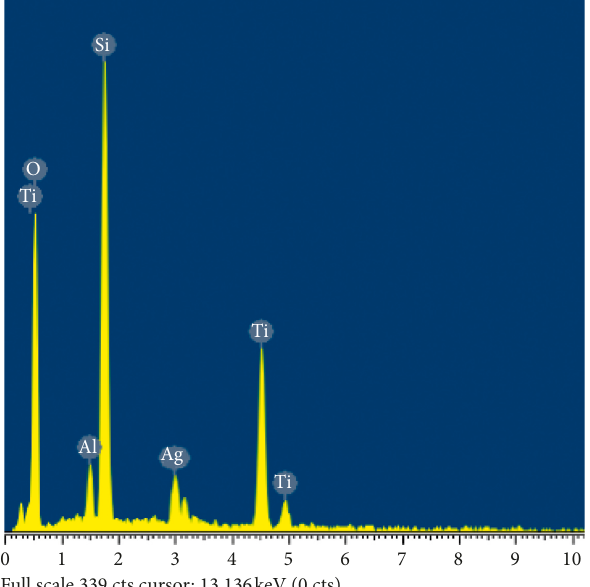
Figure 5: EDX spectrum of Al-MCM-41@0 1Ag/TiO